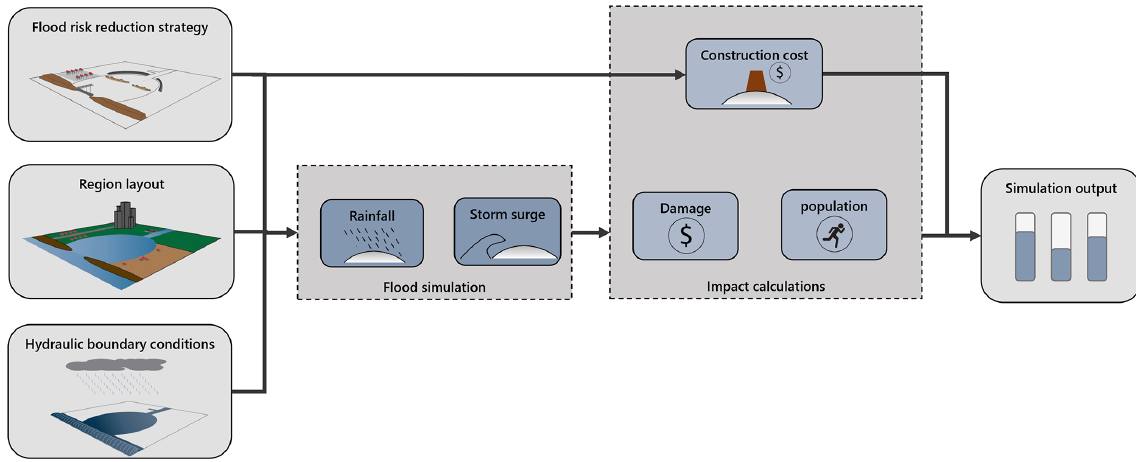
Figure 1. Schematization of a flood event simulation.